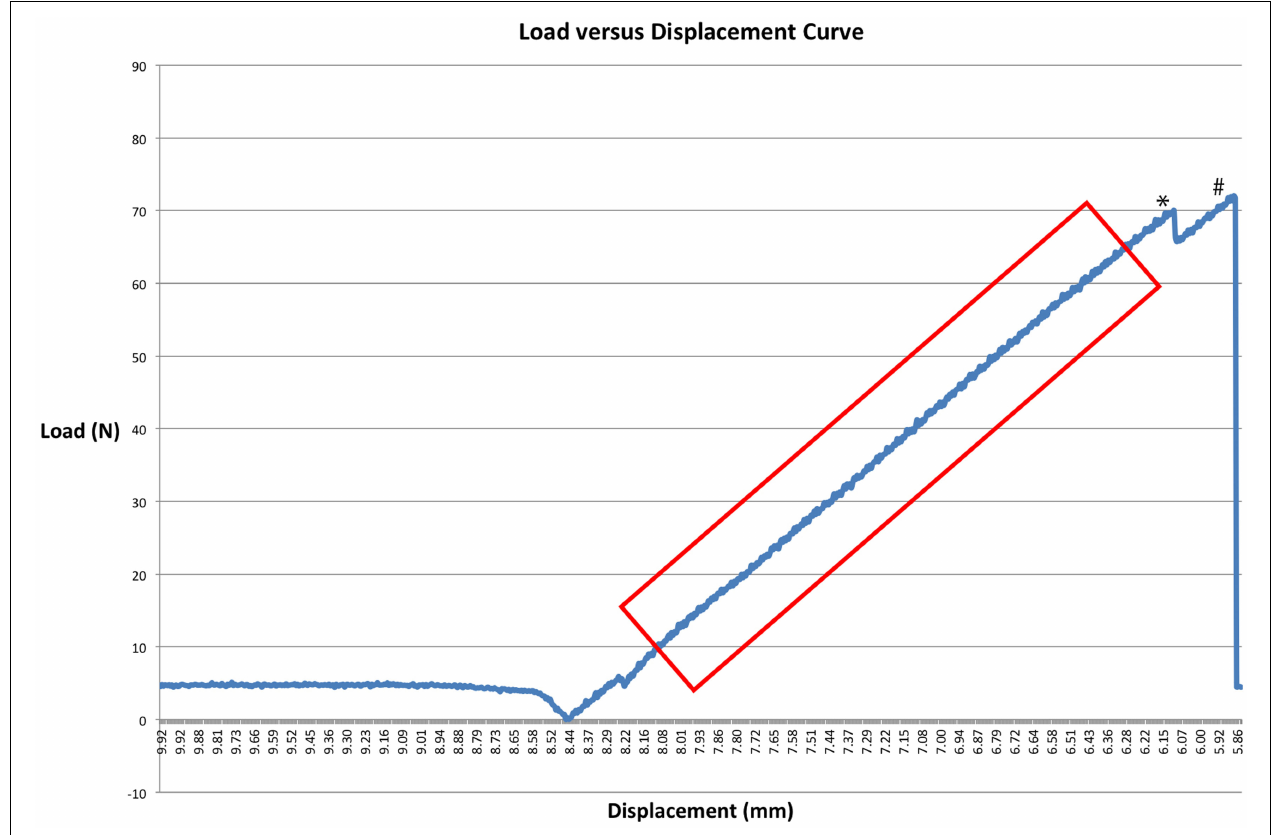
construct may demonstrate instability. # denotes ultimate failure. The box demonstrates a linear segment of the graph used to calculate the slope to determine stiffness.